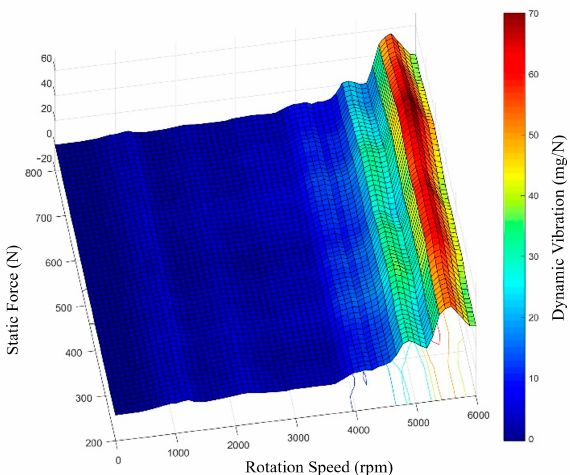
Figure 15. Spindle vibration under different rotation speed and static force.